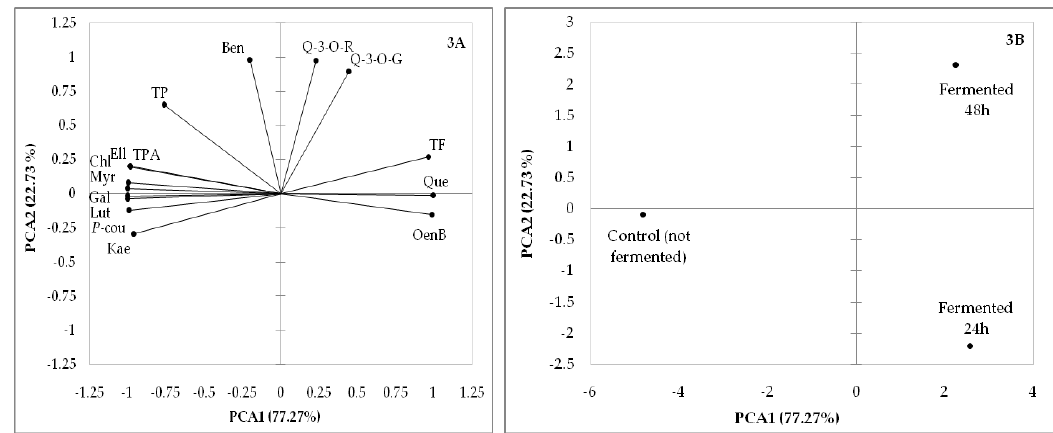
Figure 3. PCA results for the 2018 growing season: ( 3A ) factor loadings for polyphenols (total polyphenols (TP), total flavonoids (TF), quercetin-3-O-rutinoside (Q-3- O -R), myricetin (Myr), luteolin (Lut), quercetin (Que), quercetin-3- O -glucoside (Q-3- O -G), kaempferol (Kae), total phenolic acids (TPA), gallic (Gal), chlorogenic (Chl), p -coumaric ( P -cou), ellagic (Ell), benzoic (Ben), oenothein B (OenB)) and ( 3B ) projection of fireweed samples fermented for di ff erent durations (control (not fermented), fermented 24 h and fermented 48